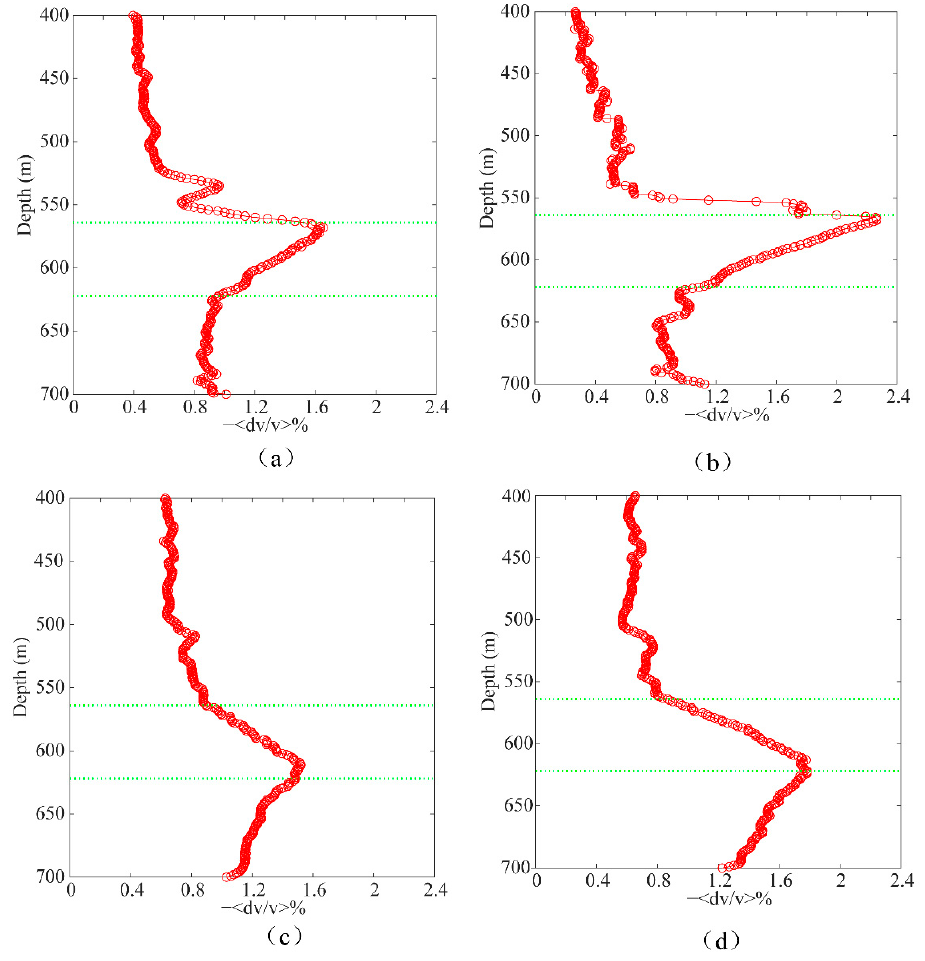
Figure 11. The estimated mean velocity change versus the receiver depth from the first-repeat survey and second-repeat survey using ( a ) CWI processing of the upgoing waves of the vertical component, ( b ) CWI processing of the upgoing waves of the horizontal component, ( c ) CWI processing of the downgoing waves of the vertical component, and ( d ) CWI processing of the downgoing waves of the horizontal component, respectively. The CO 2 leakage layer is indicated by green dotted lines.